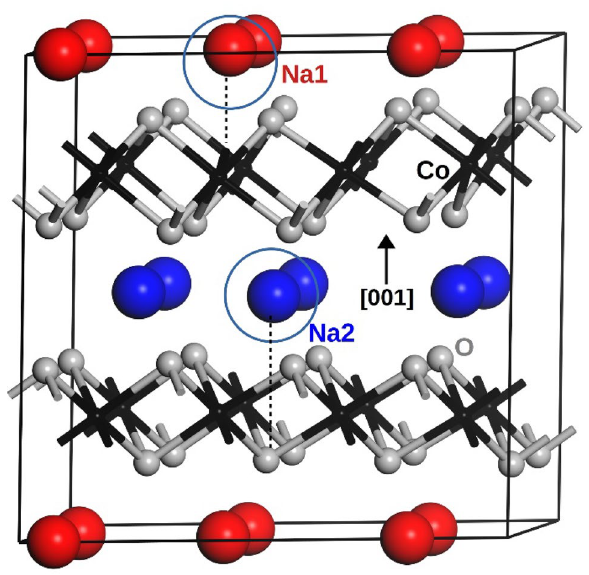
Fig. 4 A schematic presentation of the Na 0.75 CoO 2 structure con- structed out of a desodiated 4 a × 2 a × 1 c supercell of the P 6 3 /mmc Na 1 CoO 2 primitive cell. Co and O ions occupy the Wyckoff 2a and 4f sites of the hexagonal lattice structure, respectively. In Na x CoO 2 , some of the Na ions occupy 2b (Na1) sites which share basal coordi- nates with Co, while the rest of of the Na ions occupy 2c (Na2) sites which share basal coordinates with O. There are two layers of Na ions (and two layers of CoO 2 ) in the unit cell. Na ions at Z = 0 are pre- sented in red, while Na ions at Z = 0.5 are presented in